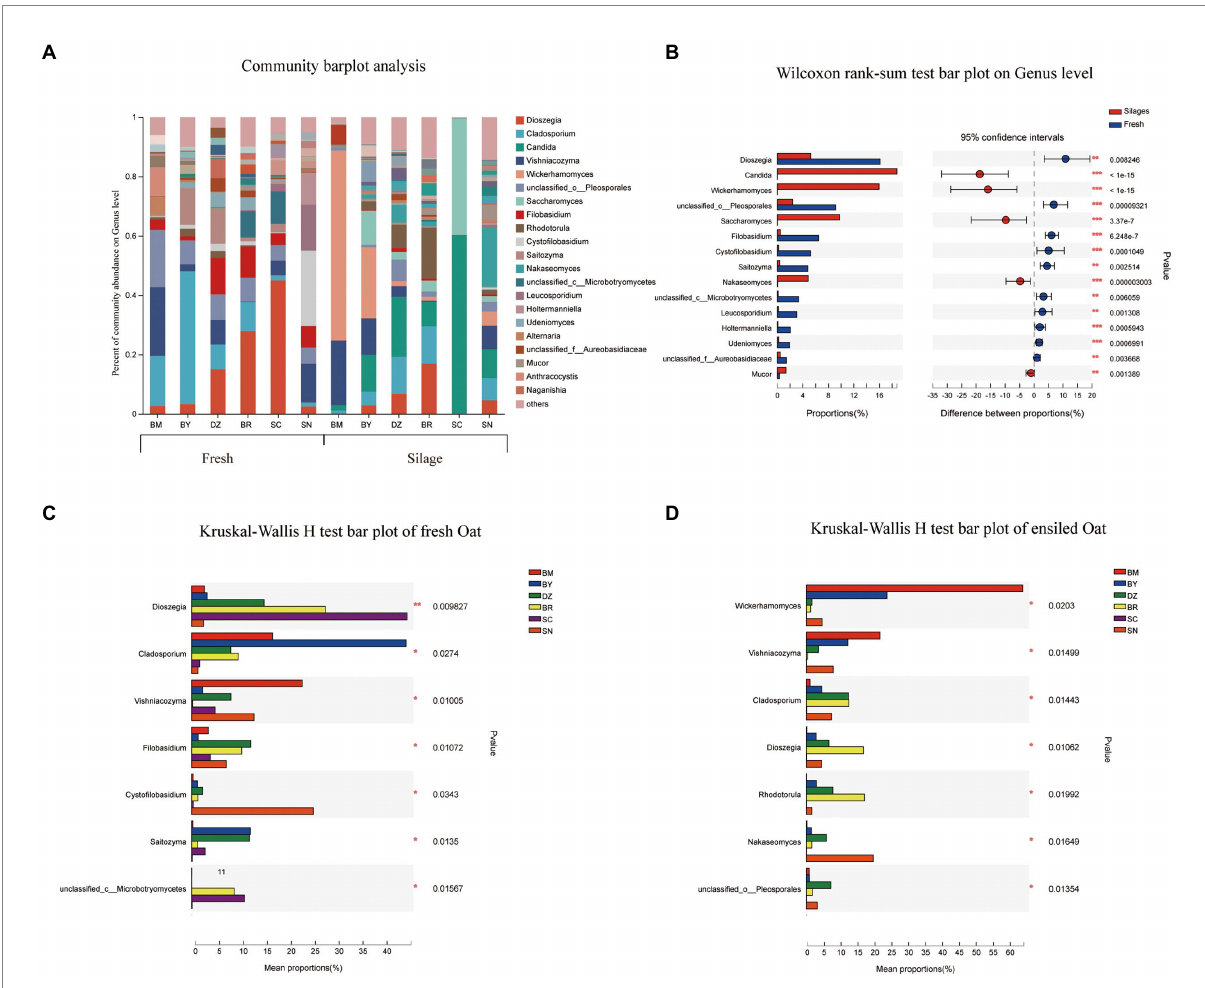
FIGURE 4 Fungal community composition of fresh and ensiled oat along the elevation gradient on the Tibetan Plateau. (A) The bar plots of fungal community composition of fresh and ensiled oat at the genus level. (B) Extended error bar plot showing the most abundant Fungal genus that had significant differences between fresh and ensiled oat. Positive differences in mean relative abundance indicate the Fungal genus overrepresented in fresh oat, while negative differences indicate greater abundance in oat silages. (C) Relative abundances of fungal genera showed significant differences among fresh oat. A one-way ANOVA was used to evaluate the significance of differences between the indicated groups. * p < 0.05,** p < 0.01,*** p < 0.001. (D) Relative abundances of fungal genera showed significant differences among oat silages. A one-way ANOVA was used to evaluate the significance of differences between the indicated groups. * p < 0.05,** p < 0.01,*** p <